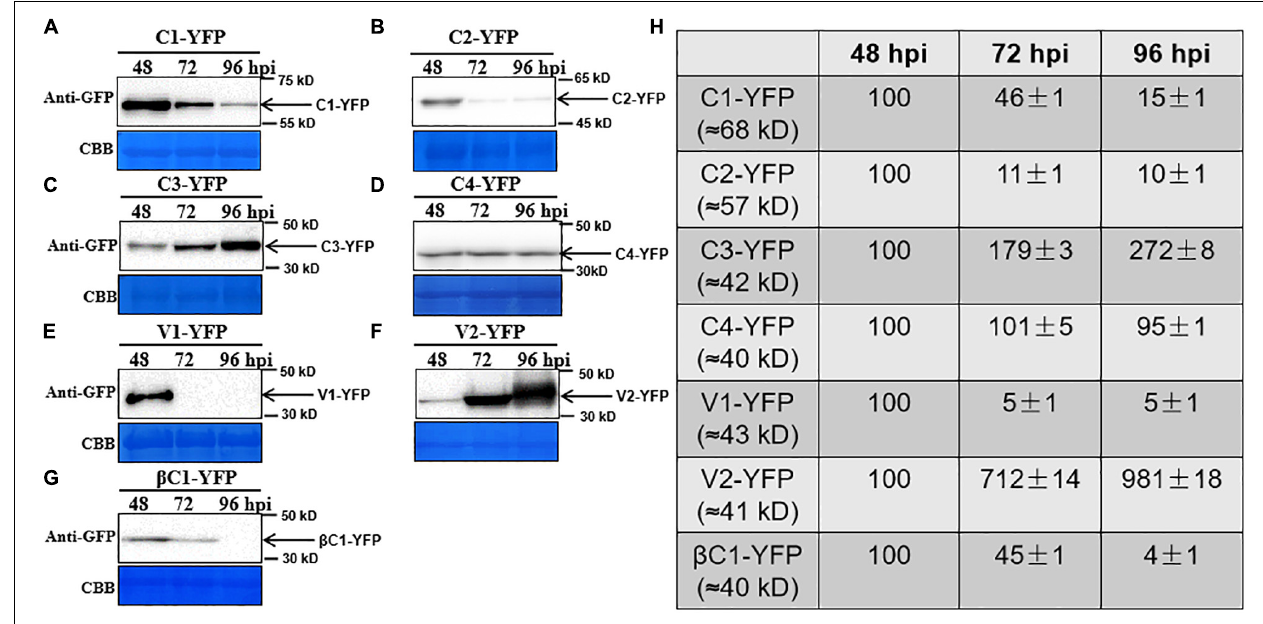
FIGURE 3 | Dynamic changes in the accumulation of viral proteins. (A–G) N. benthamiana leaves were infiltrated with 0.5 ml of Agrobacterium cultures to express C1-YFP, C2-YFP, C3-YFP, C4-YFP, V1-YFP, V2-YFP, or β C1-YFP adjusted to an optical density at 600 nm (OD 600 ) = 0.8. Total proteins were extracted from C1-YFP, C2-YFP, C3-YFP, C4-YFP, V1-YFP, V2-YFP, or β C1-YFP infiltrated zones at 48, 72, or 96 hpi. C1-YFP (A) , C2-YFP (B) , C3-YFP (C) , C4-YFP (D) , V1-YFP (E) , V2-YFP (F) , or β C1-YFP (G) at 48, 72, or 96 hpi were detected with an anti-GFP antibody. Arrows indicate the expected protein size. All immunoblotting assays